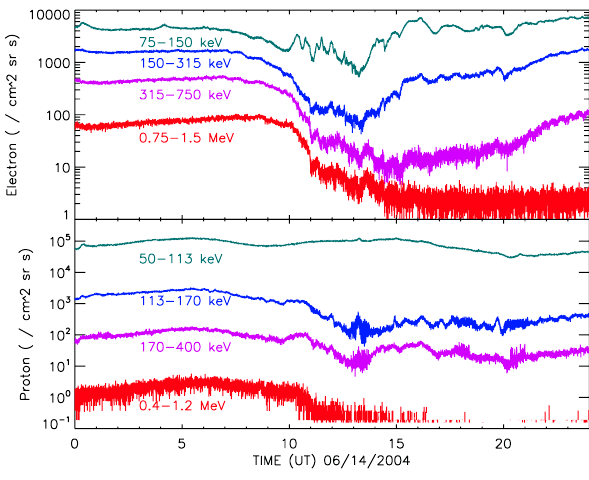
Fig. 1. Electron (top) and proton (bottom) flux observed by LANL- 02A on 14 June